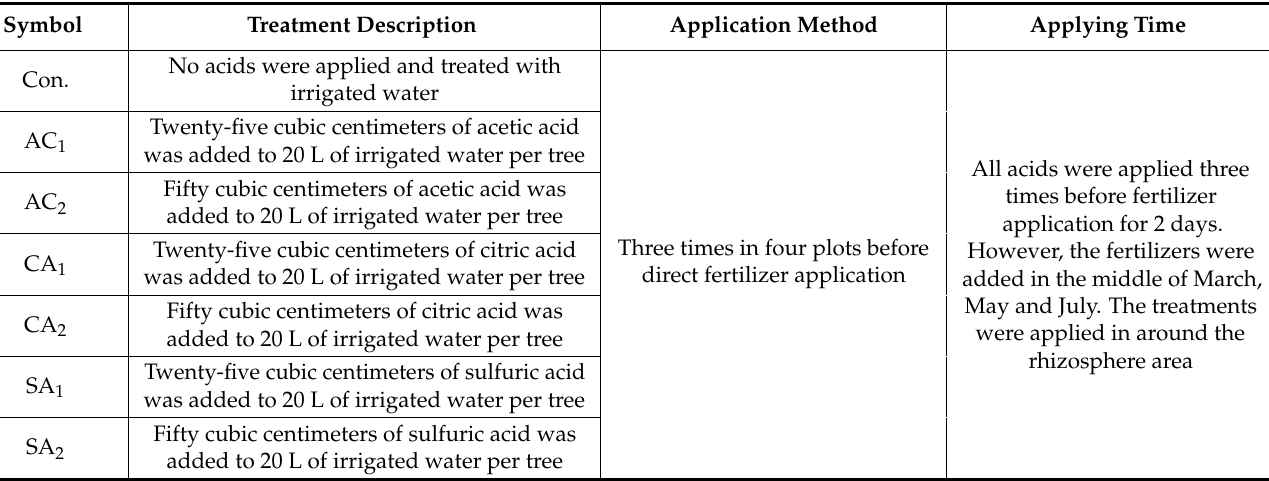
Table 2. The description of treatments applied, application method, and applying time in the field experiment. Application